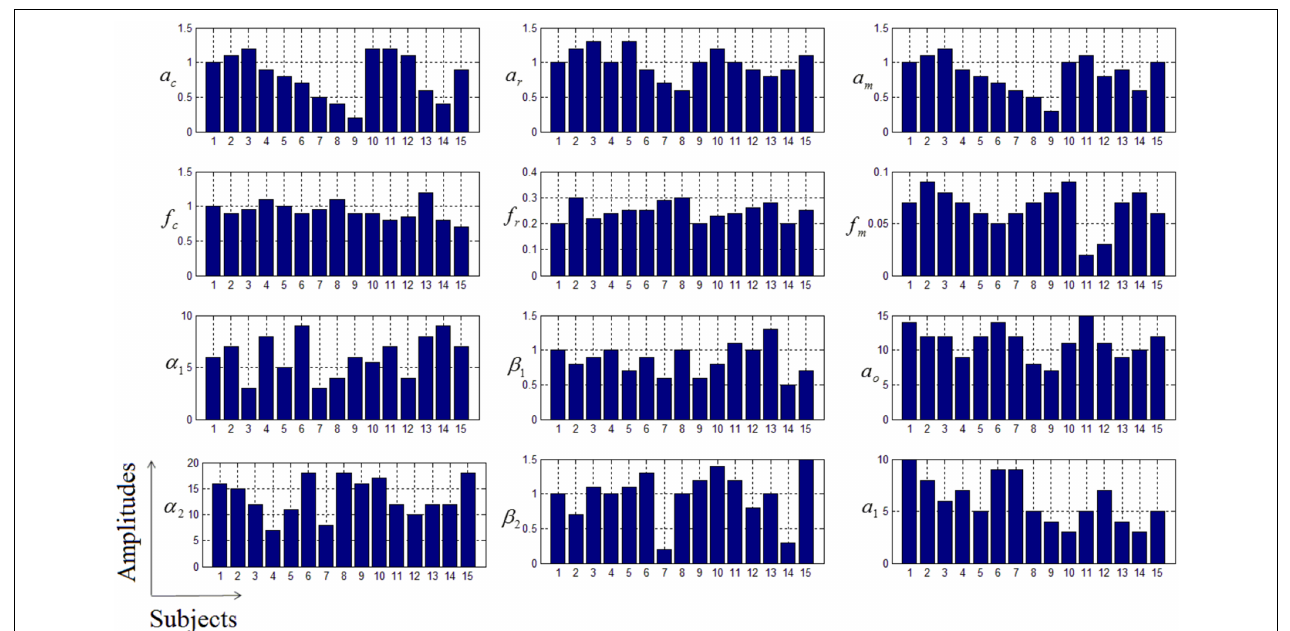
FIGURE 8 | Variations in the estimated parameters in simulated data sets.